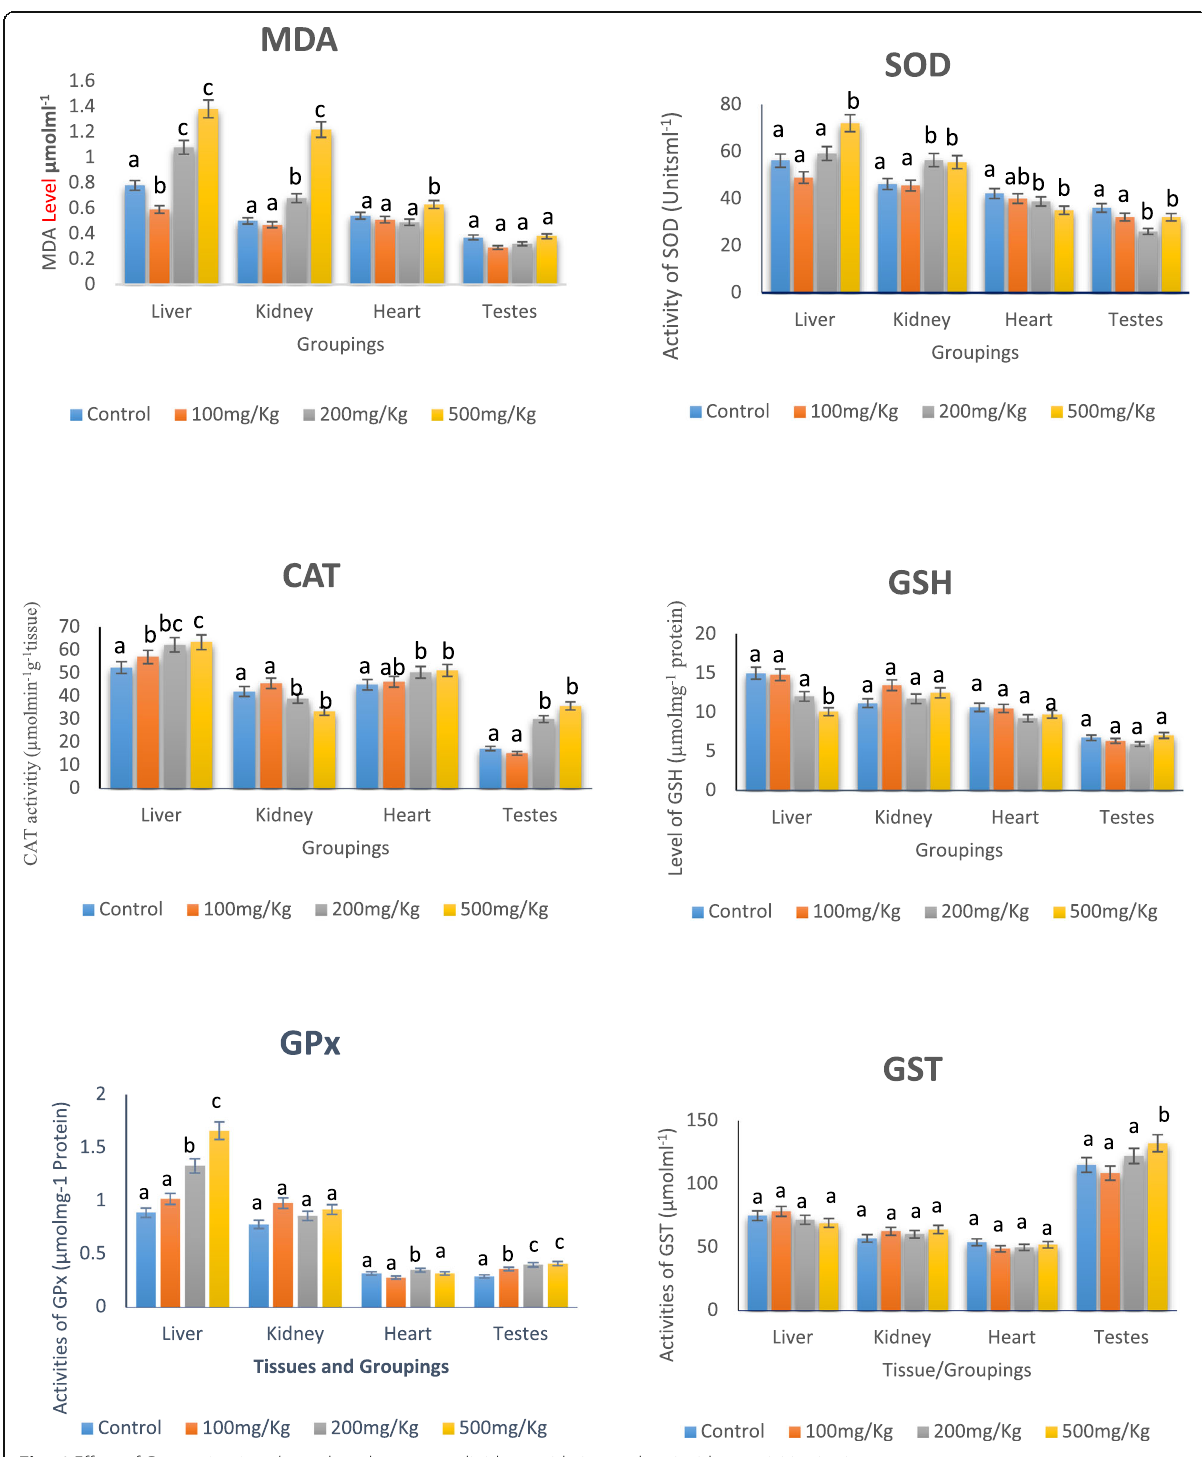
Fig. 6 Effect of Dennettia tripetala methanol extract on lipid peroxidation and antioxidant activities in